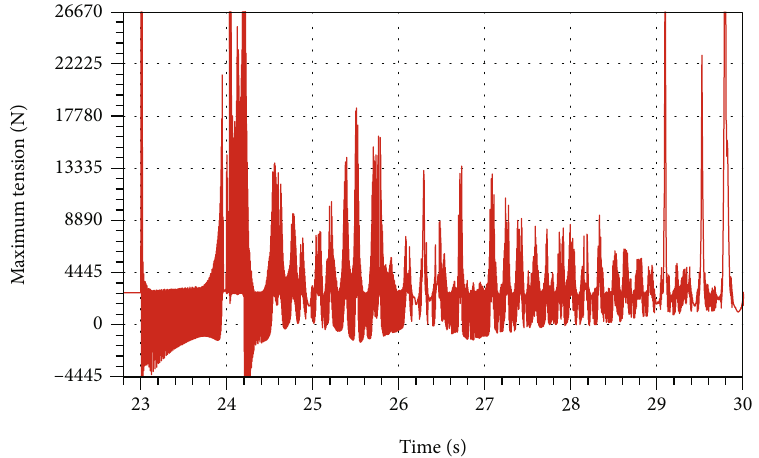
Figure 7: Tension history of case W2E0.